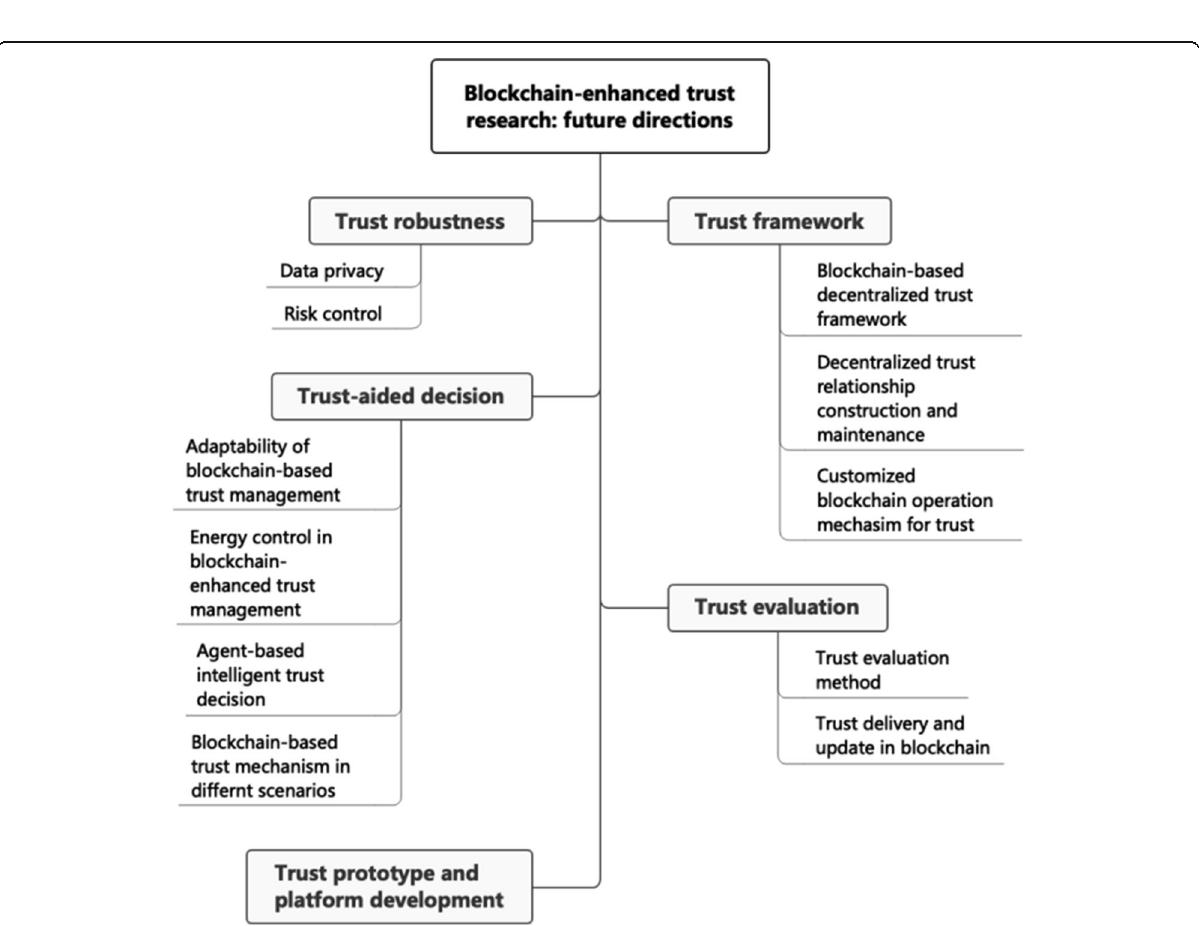
Fig. 23 Future research directions in blockchain-based trust